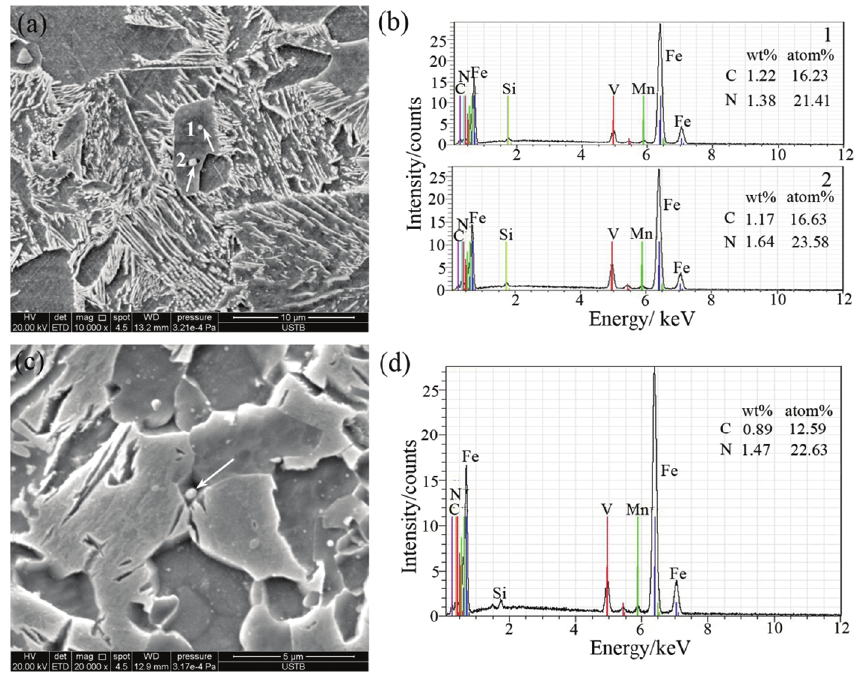
Figure 7: SEM morphologies and energy spectrums of V(C,N) particles in the ferrite and bainite microstruc- ture: (a)(b) the phase of ferrite; (c)(d) the phase of